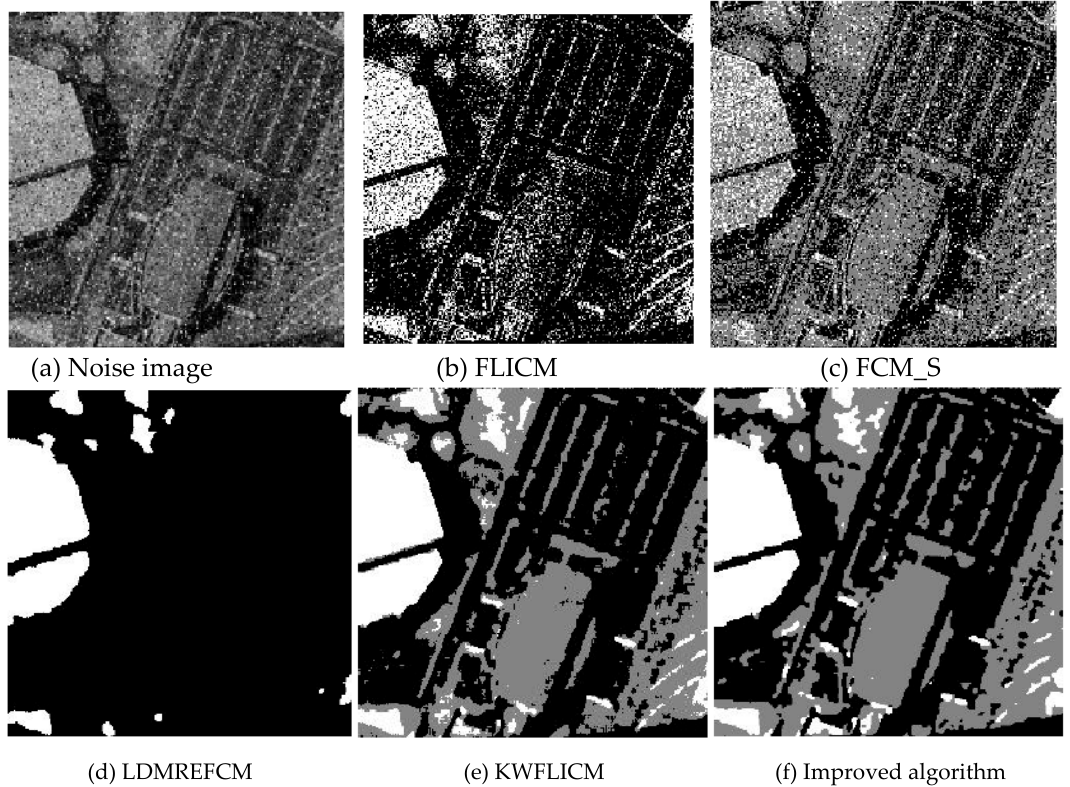
Figure 17. Interference of mixed noise on the stadium image ( a ) and the segmentation results ( b – f ).